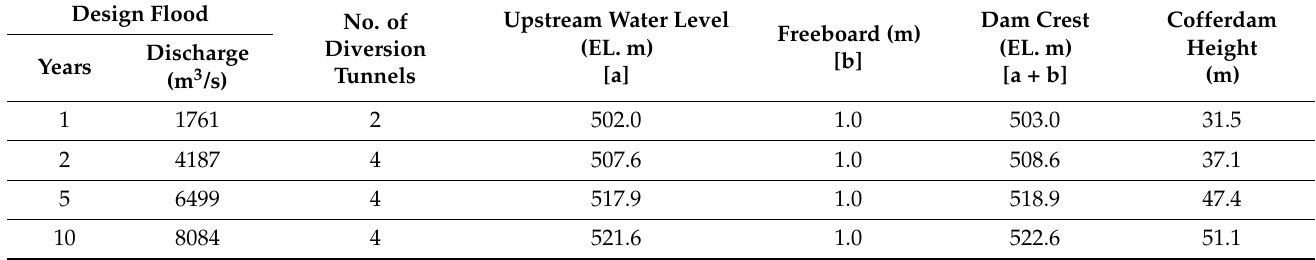
Table 1. Flood routing